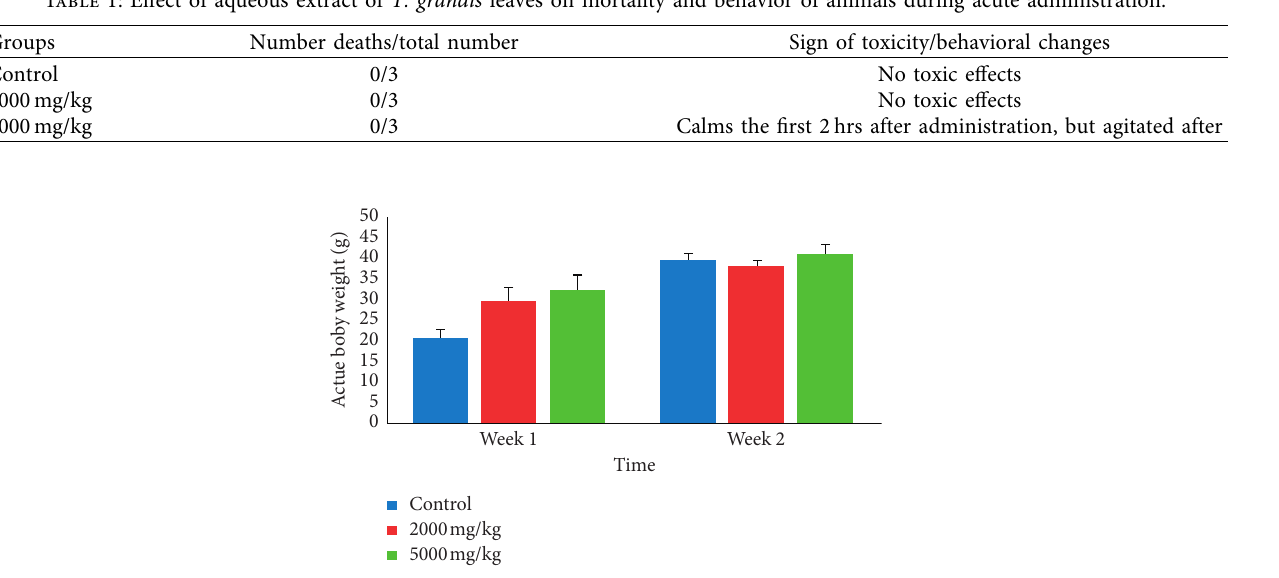
Figure 1: Evolution of body weight during acute administration of aqueous extract of T. grandis leaves. Data are expressed as mean ± SD, n � 4. Values for a given group in a column followed by a different letter as superscript are significantly different according to Wal- ler–Duncan’s multiple comparison test ( p < 0.05). Table 2: Effect of aqueous extract of T. grandis leaves on relative organ weights of animals after 14 observation days. Groups